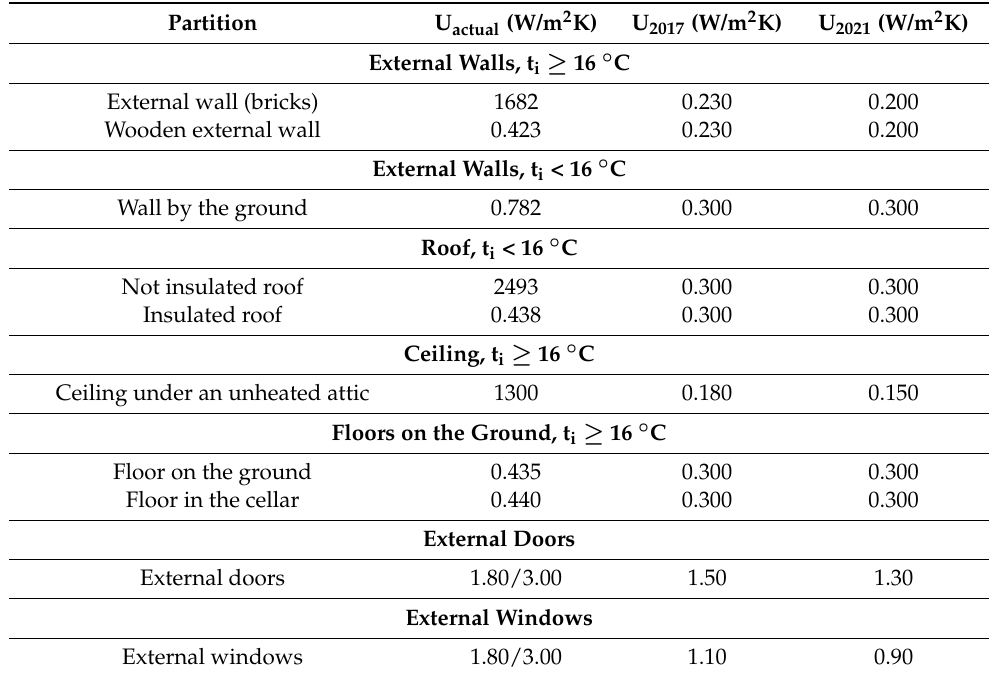
Table 2. Thermal parameters of external partitions before modernization against technical require- ments for buildings from the 2017 year (WT2017) and 2021 year (WT2021). Partition U actual (W/m 2 K) U 2017 (W/m 2 K) U 2021 (W/m 2 K) External Walls, t i ≥ 16 ◦ C External wall (bricks) 1682 0.230 0.200 0.423 0.230